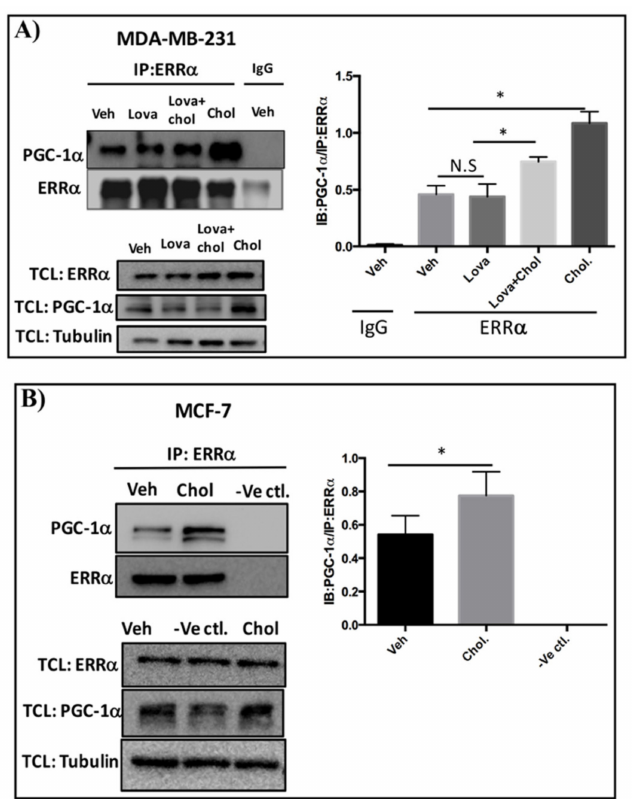
Figure 2. Cholesterol enhances ERR α -PGC-1 α interaction in breast cancer cells. ( A ) MDA-MB-231 cells were treated with vehicle (Veh), lovastatin (Lova), lovastatin + cholesterol (Veh + Chol) or cholesterol (Chol) at 5 µ M for 24 h. Cell lysates were subjected to immunoprecipitation (IP) with anti-ERR α or control IgG antibody. The protein complexes were separated by SDS-PAGE and immunoblotted (IB) with anti-PGC-1 α or anti-ERR α antibodies to detect PGC-1 α as a co-immunoprecipitated protein and ERR α as an immunoprecipitated protein. 2% of total cell lysate (TCL) were used to detect the endogenous levels of ERR α and PGC-1 α . To quantify PGC-1 α / ERR α ratio, densitometry analysis of PGC-1 α and ERR α proteins derived from the same immunoblot was performed using ImageJ software. ( B ) MCF-7 cells were treated with vehicle (Veh) or cholesterol (Chol) at 10 µ M for 24 h. Immunoprecipitation was performed using a Pierce co-immunoprecipitation (Co-IP) kit. The cell lysates were incubated with the AminoLink Plus Coupling Resin and immunoprecipitated with an ERR α antibody. Also as a negative control (-Ve Ctl.), the vehicle-treated cell lysate received the same concentration of anti-ERR α antibody except that the AminoLink Plus Coupling Resin was replaced with a Pierce Control Agarose Resin that is not amine-reactive, preventing ERR α antibody from binding to the resin. The bound proteins were eluted and separated by SDS-PAGE and immunoblotted with anti-PGC-1 α or anti-ERR α antibodies to detect PGC-1 α as a co-immunoprecipitated protein and ERR α as an immunoprecipitated protein, respectively. 2% of TCL were used to detect the endogenous protein levels of ERR α and PGC-1 α . To quantify PGC-1 α / ERR α ratio, densitometry analysis of PGC-1 α and ERR α proteins derived from the same immunoblot was measured using ImageJ software. A minimum of 3 independent experiments were performed. A value of p < 0.05 was considered significant